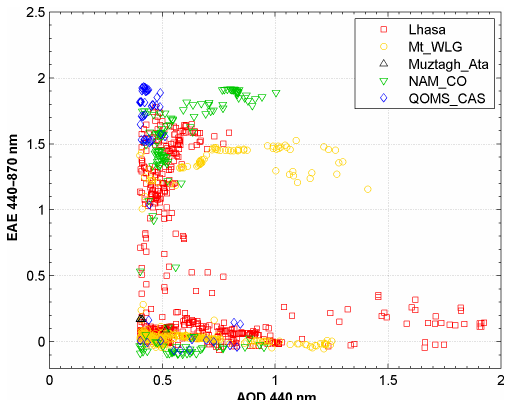
Figure 10. AOD vs. EAE (only CE318_AOD at 440nm > 0.4 was considered) observed by CE318 at the five sites on the Tibetan